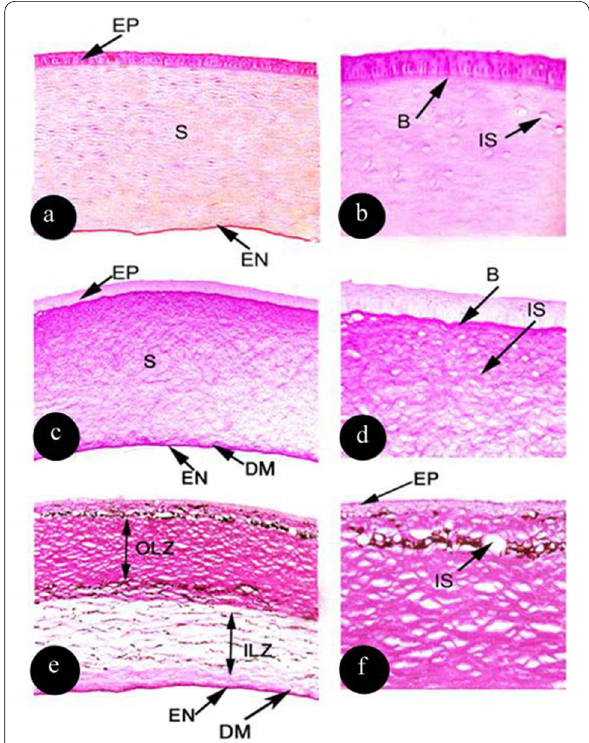
Fig. 1 Photomicrograph of transverse section of cornea of Eudocimus albus ( a , b ), Anas platyrhynchus ( c , d ) and Buteo buteo ( e , f ). a , c , e H&E X 100. b , d , f higher magnification (H& E X